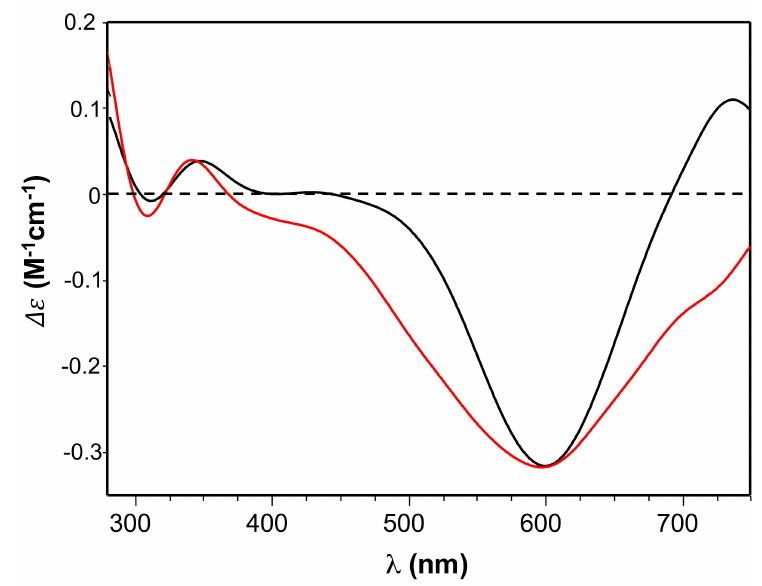
Figure 2. Circular dichroism (CD) spectra of Ang 60–68 + CuSO 4 (black line) and Ang 60–68 Cys + CuSO 4 (red line) at pH = 7.4. Equimolar concentration of peptide and copper were used: [peptide] = [Cu(II)] = 1 × 10 − 3